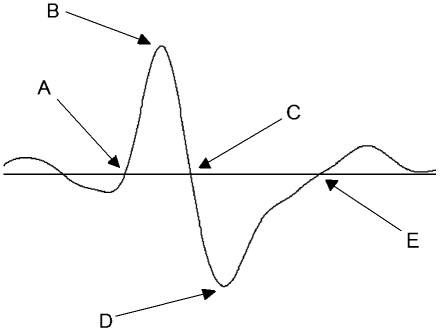
Schematic view of a detected SW and its characteristics.SW amplitude is calculated as the difference in voltage between the negative peak-B and the positive peak-D of unfiltered signals expressed in µV. SW frequency represents the number of cycle per minute (i.e. the inverse of total duration which is the number of sec between A and E). SW negative duration is calculated using the number of sec between A and C, and positive duration by the number of sec between C and E. SW slope represents the velocity of the change between the negative peak-B and the positive peak-D expressed in µV/sec. Per convention, the scale indicates negative up and positive down.